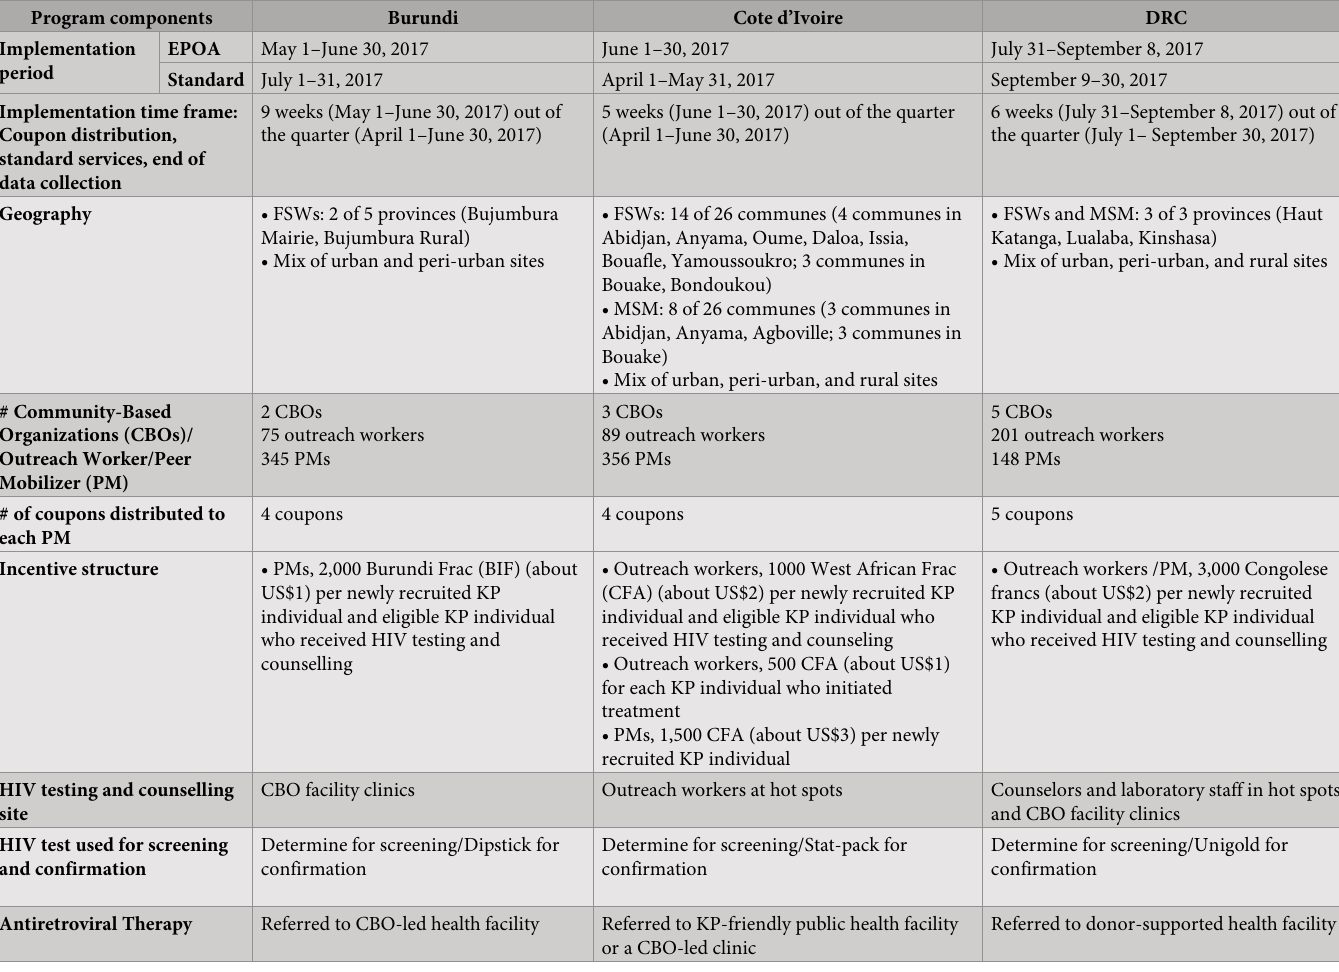
Table 1. EPOA implementation in Burundi, Cote d’Ivoire, and DRC,